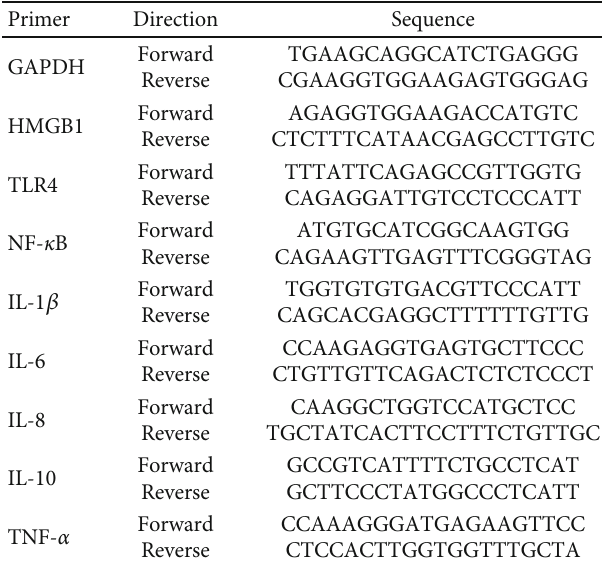
Table 1: List of